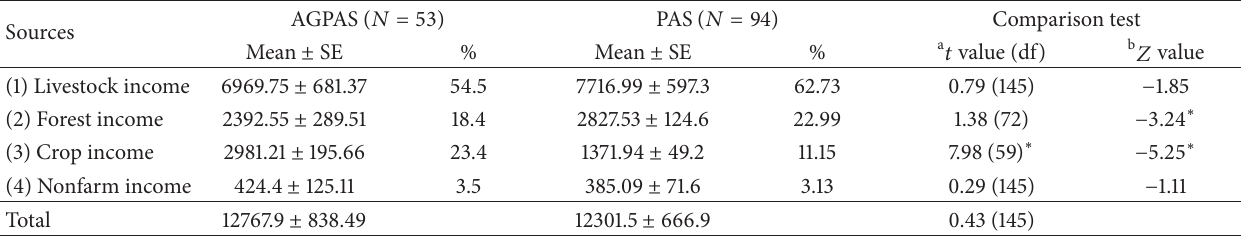
Table 2: Mean annual income (in ETB) of pastoral and agropastoral households from different